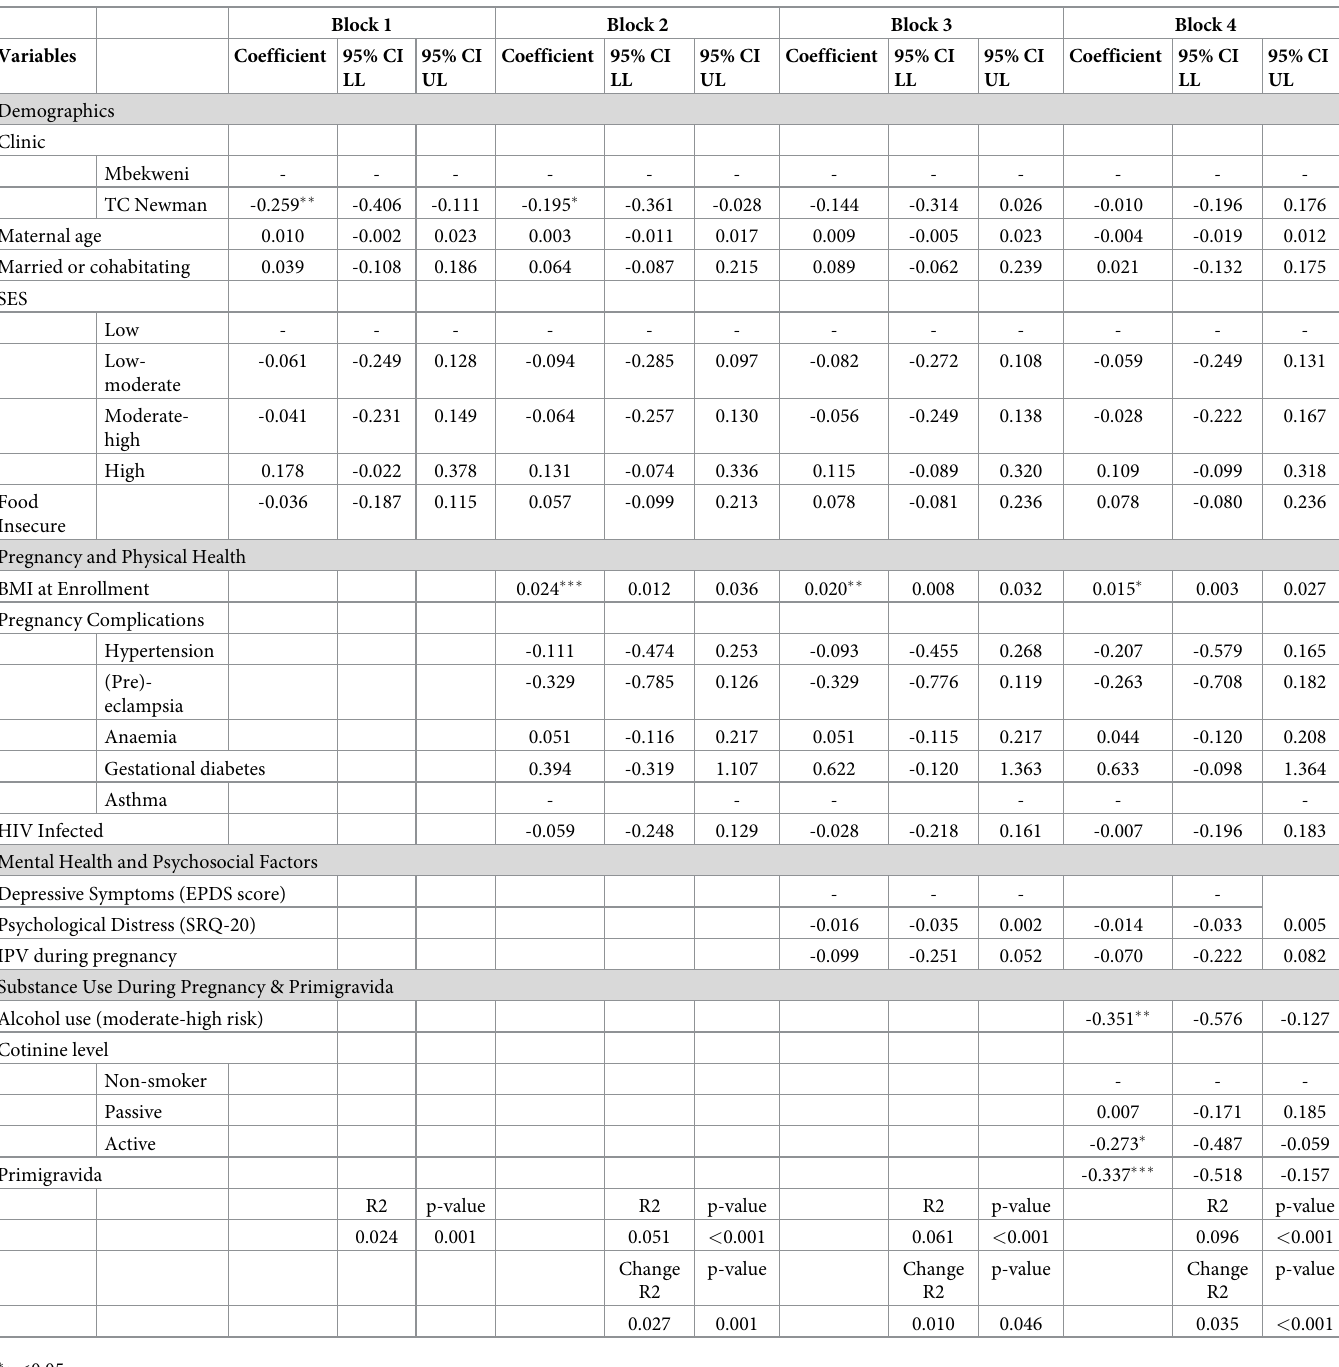
Table 4. Hierarchical regression predicting birth weight for gestational age (Z-score; N Final model =